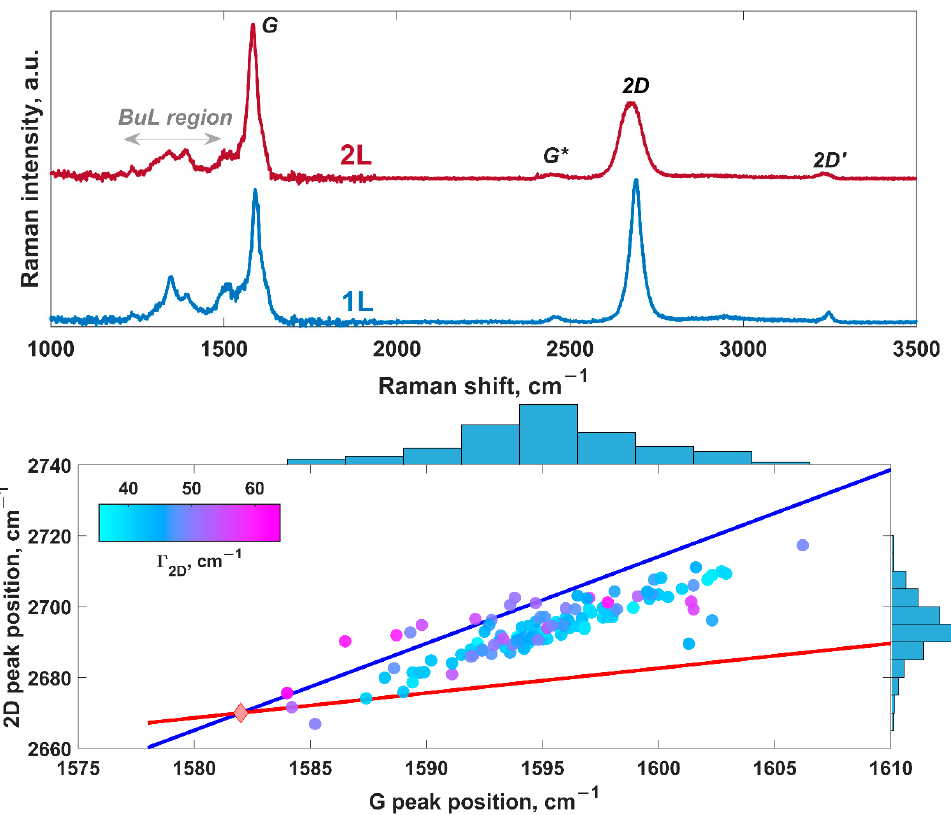
Figure 4. ( Top panel ) Raman spectra of monolayer ( bottom ) and bilayer ( top ) epitaxial graphene. ( Bottom panel ) 2 D peak position vs. G peak position for bilayer-patched epitaxial graphene color- coded by FWHM (full width at half maximum, Γ 2 D ) of the 2 D peak. Corresponding histograms of 2 D peak and G peak positions are also demonstrated. The reddish diamond designated by NP represents the neutrality point of free-standing graphene, without doping and strain effects. The blue and the red solid lines correspond to the so-called strain and doping lines for free-standing graphene.